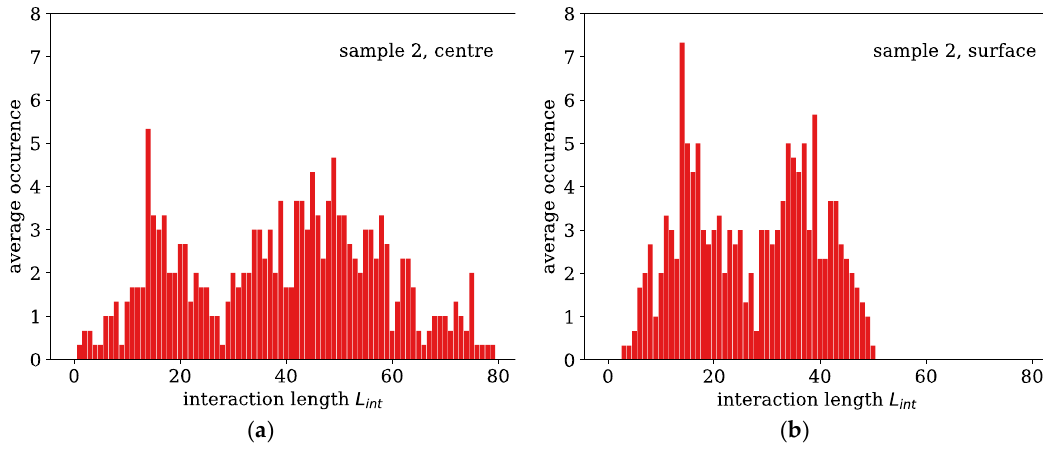
Figure 9. Two exemplary histograms of the interaction lengths in sample 2 at the fibre axis ( a ) and the surface ( b ). There is an obviously larger alignment near the fibre axis.